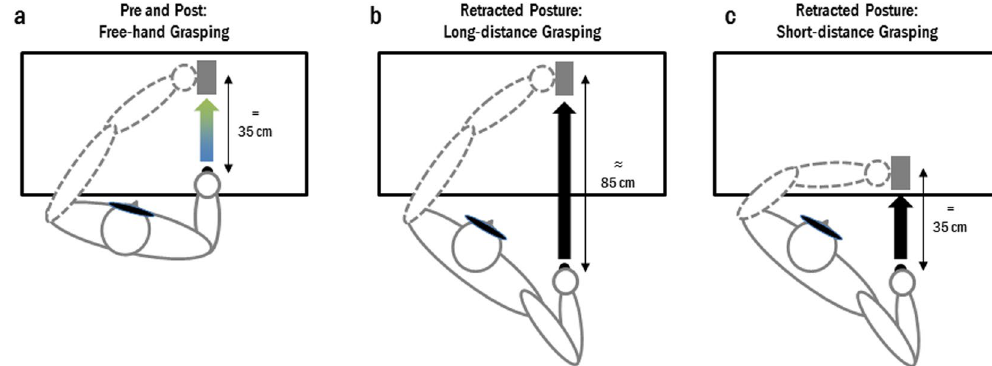
Figure 6. Experimental set-up for Experiment 2. ( a ) A wooden object was placed on the table in front of the starting position, at 35 cm. Before and after the two sessions with retracted starting posture, inducing either a long- ( b ) or short-distance ( c ) grasping movement, participants reached out and grasped the wooden target object with their right hand upon hearing a go signal. ( b ) In the Long-Distance session the initial posture was the same as the one assumed while using a 40cm-long grabber in Experiment 1, with the object to grasp at the same position than in the pre and post tool use sessions (e.g. about 85 cm from this new starting point). ( c ) In the “Short-Distance” session participants maintained the same initial posture as in the Long-Distance session while the target object was positioned 35 cm from the acting hand.